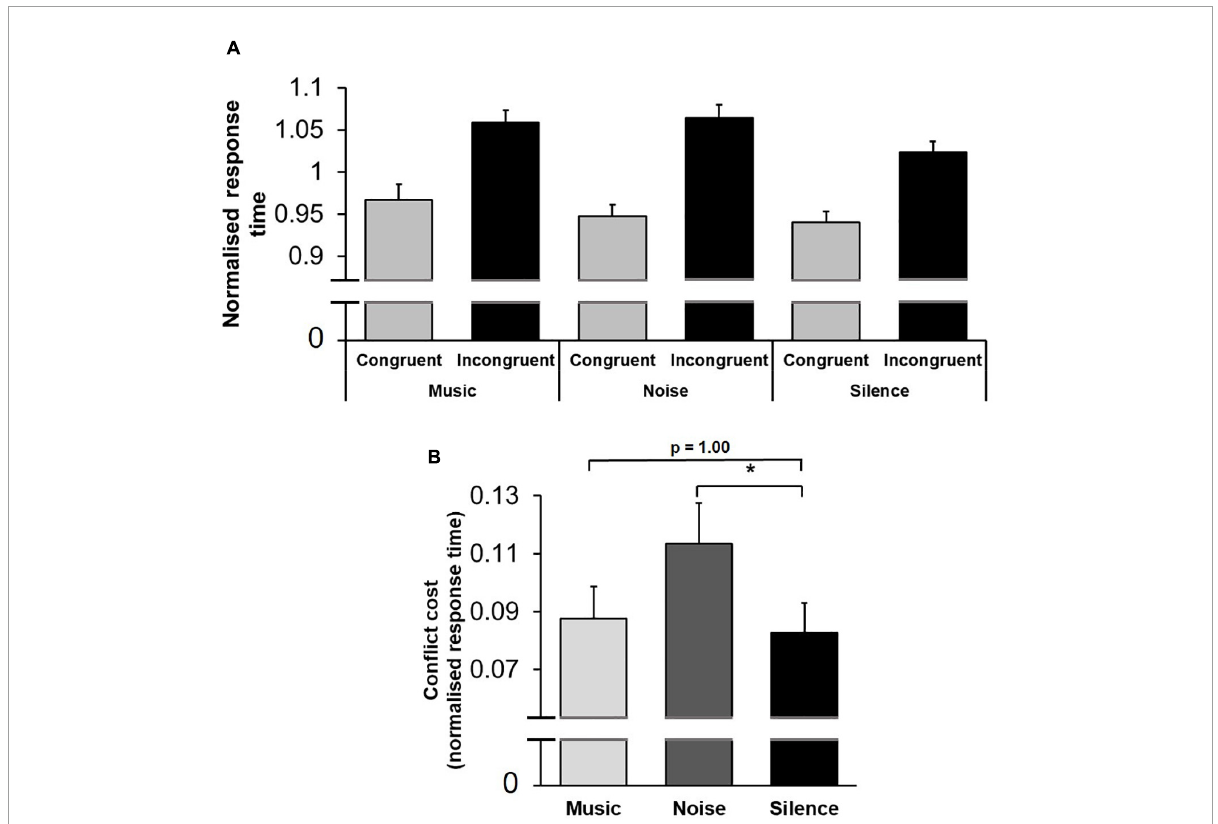
FIGURE4 Conflict cost was modulated by the background acoustic condition. (A) Mean normalised response time is shown for congruent and incongruent trials in each background acoustic condition. The acoustic environment modulated the conflict-induced alterations in response time. (B) The difference in mean normalised response time between congruent and incongruent trials (conflict cost) is shown for each background acoustic condition. Compared to silence, white noise increased the conflict cost. *represents p < 0.05. Error bars represent standard error of the mean